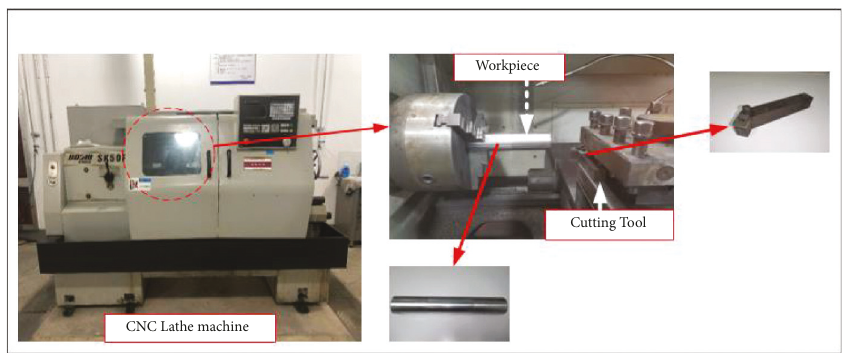
Figure 1: Experimental